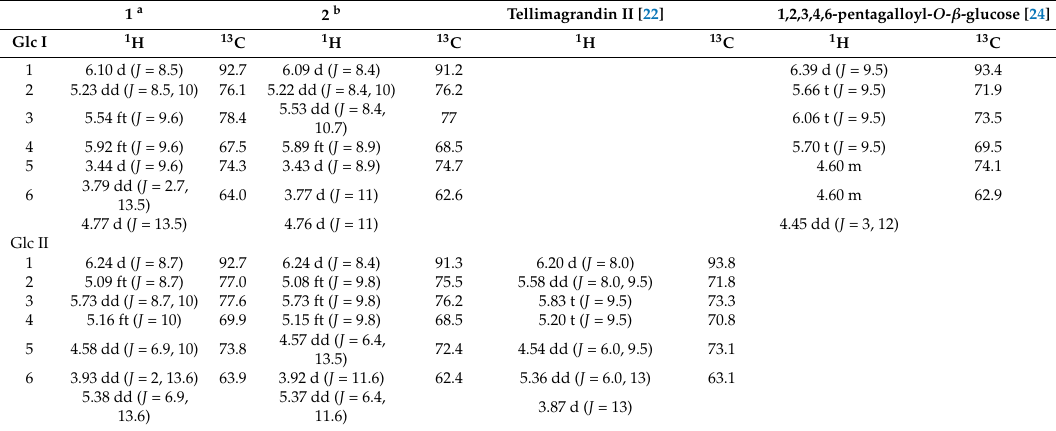
Table 2. 13 C and 1 H-NMR data of merianin A ( 1 ) and merianin B ( 2 )